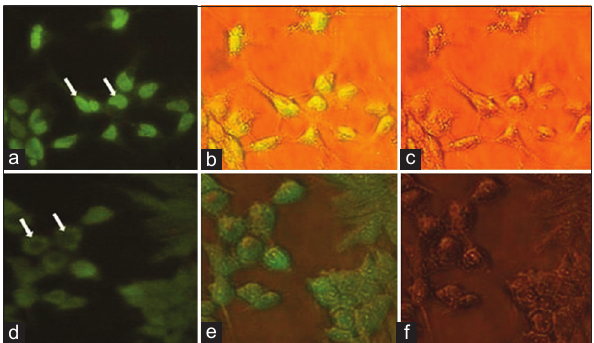
Figure-5: Immunostaining analysis of signal transducer and activator 3 (STAT3) phosphorylation by bacterial expressed bovine interleukin 7 (IL-7) matureprotein (400 × magnifications). 10 5 cells per well were seeded in six- well plates and incubated with 10 μ g/ml recombinant IL-7 mature protein. Cells were fixed with formaldehyde and permeabilized with Triton-100. Cells were incubated with anti-phospho-STAT3 (Tyr705) antibodies and conjugated with secondary antibody tagged with fluorescein isothiocyanate (FITC) and visualized under fluorescent microscope. (a) cells under ultra-violet [UV] light shows more fluorescence in the nucleus than the cytoplasm, (b) cells were visualized under both UV and plain light, (c) cells illuminated with plain light showing no fluorescence, (d) Control cells show less fluorescence compared nueclues when illuminated under UV light, (e) same cells visualized under UV and plain light, (f) cells visualized under plain light shows no fluorescence . Control cells not showing any fluorescence in the nucleus and only cytoplasm is stained.Cells incubated with recombinant IL-7 mature protein show fluorescence in the nucleus showing localization of STAT3 molecules in the